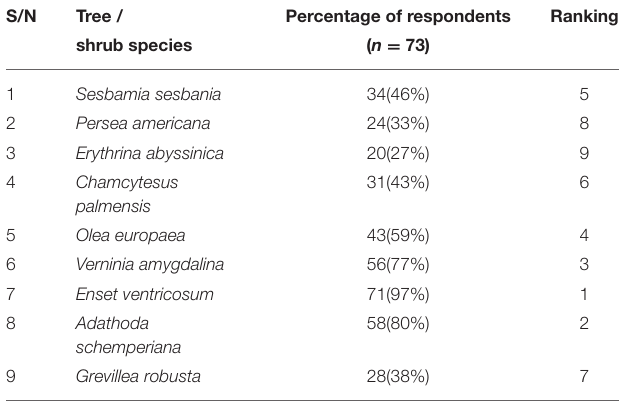
TABLE 5 | Trees and Shrubs used for Fodder and preference ranking.